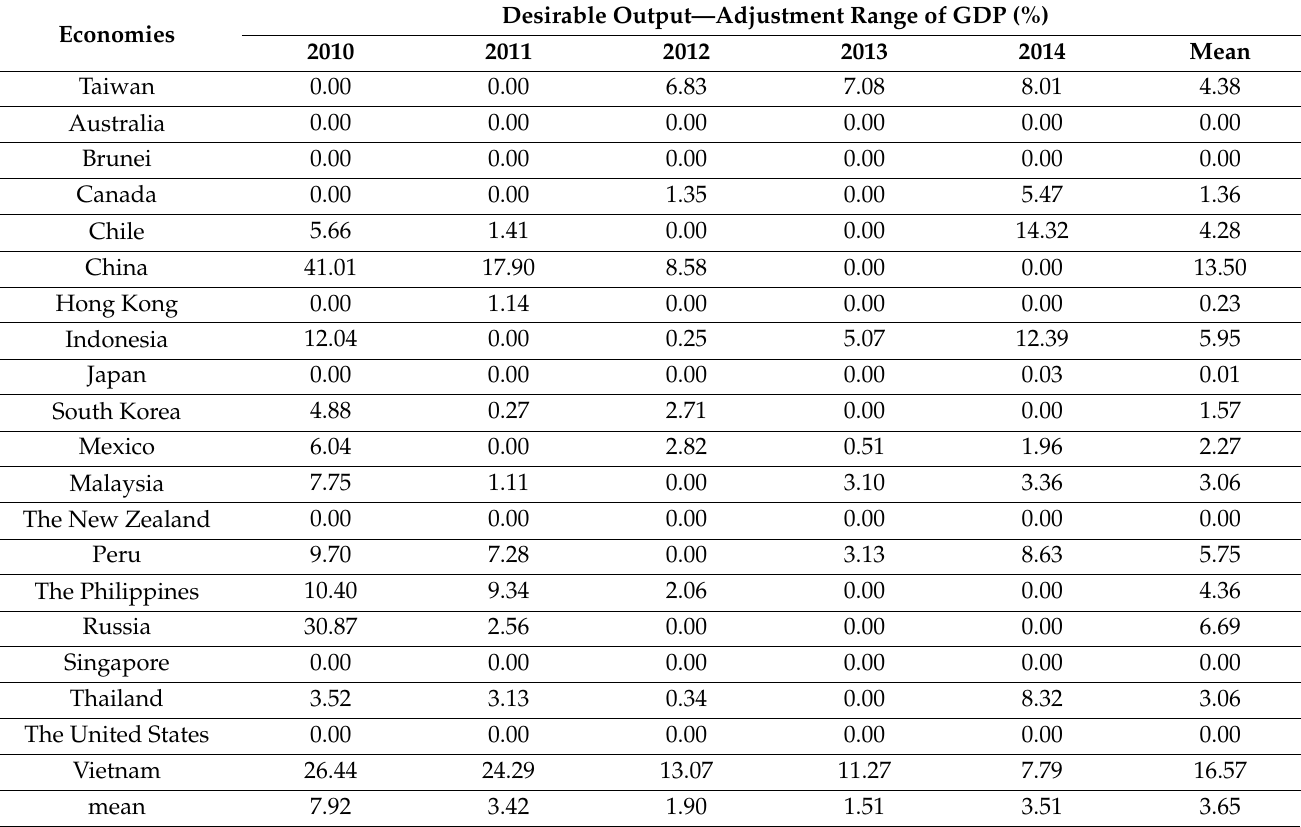
Table 9. The adjustment of the intertemporal conversion variable GDP for APEC economies from 2010 to 2014. Desirable Output—Adjustment Range of GDP Economies